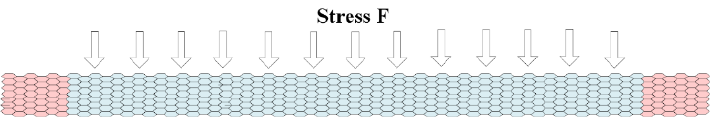
Figure 5. Schematic diagram of stress loading on the graphene structure.